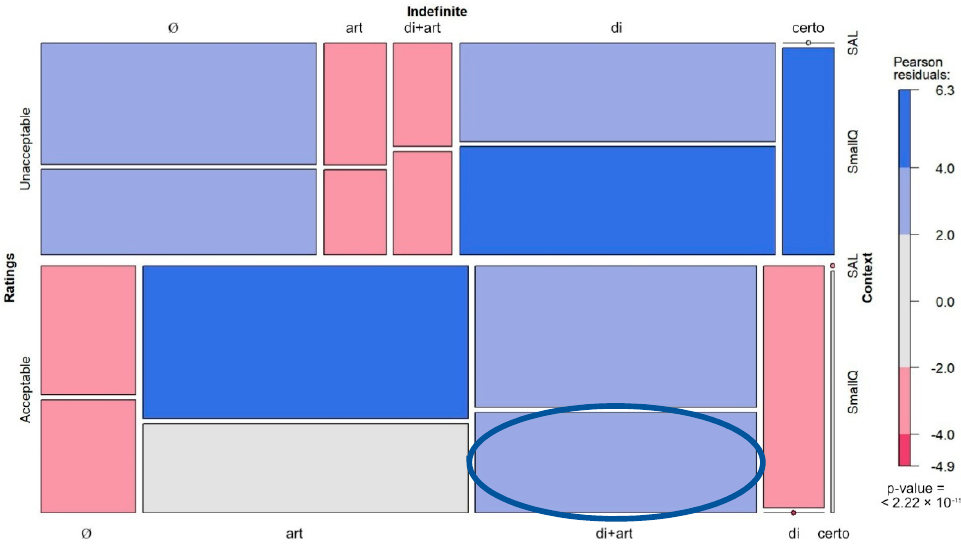
Figure 11. (Un)acceptability rate of each indefinite determiner on saliency and small quantity interpretation contexts. The blue circle highlights the greater acceptability for di +art with small quantity interpretation.